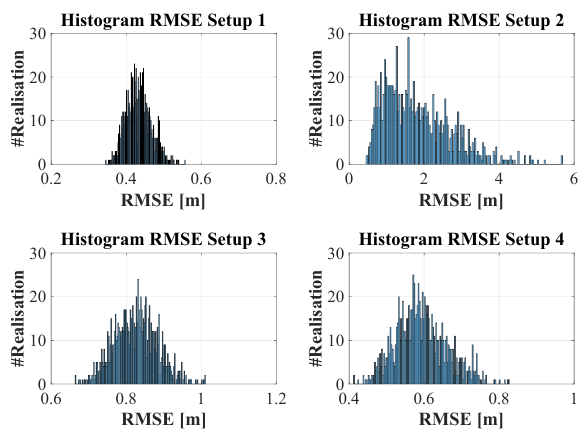
Figure 3. Histograms of the RMSE for the 1000 runs of the Monte Carlo simulation for four different sensor setups (see Table 2) of vehicle 1. Please note the different scales of the plots.